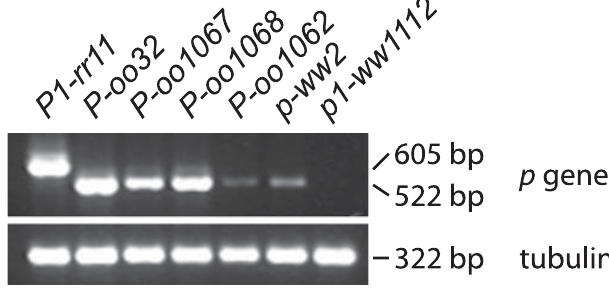
Figure 3. RT-PCR Analysis of P-oo Transcripts RNA was extracted from kernel pericarp (20 DAP), reverse transcribed, and PCR-amplified using primers complementary to both p1 and p2 transcripts. The progenitor allele (P1-rr11) shows amplification of a 605- bp band from p1. The p-ww2 and P-oo alleles show amplification of a 522-bp band characteristic of the 5 9 region of the p2 gene. The p1- ww1112 allele has a deletion of p1; the native p2 gene is intact in this allele, but is not expressed in kernel pericarp. DOI: 10.1371/journal.pgen.0020164.g003